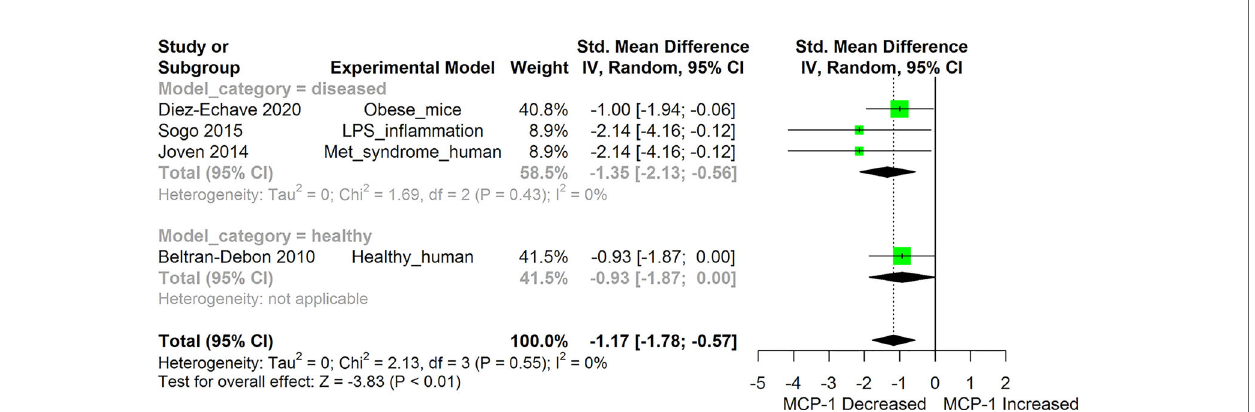
FIGURE 2 | Meta-analysis and forest plot of the effect of HS administration on Monocyte Chemoattractant Protein -1b (MCP-1/CCL2). The meta-analysis was sub- grouped by health status (i.e diseased or healthy state). The standardized mean difference (SMD), which is an estimate of the effect size, is presented as a square on the forest plot, for each study and as a diamond for the pooled estimate of each subgroup or overall studies. The overall pooled SMD for all included studies is shown in the bottom section of the forest plot. SMD data points that are lower than zero signify that treatments with HS lowered the level of the biomarker while those greater than zero indicate that HS treatment causes an increase in the levels of the biomarker. The statistical signi fi cance of the pooled estimate is indicated by the Z test of signi fi cance. LPS, Lipopolysaccharide; Met,